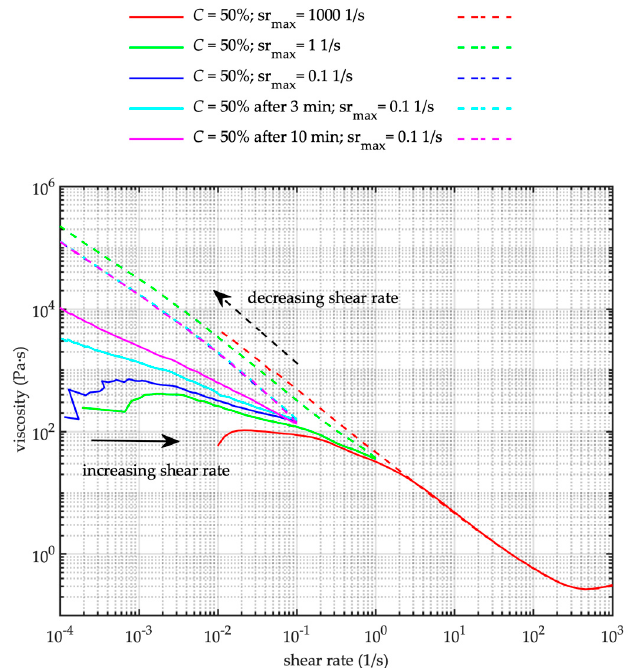
Figure 12. Apparent viscosity derived from the flow curve. Sediment concentration C = 50%. Flow curves at low shear rate after different resting times (F23, F24, F25 and F26) compared to the reference flow curve test (F22). Runs F22, F23, F24, F25 and F26 (from the top to the bottom of the legend). sr max indicates the maximum shear rate during the test. ⎯ increasing shear ramp (time 0–60 s); - - decreasing shear ramp (time 60–0 s).